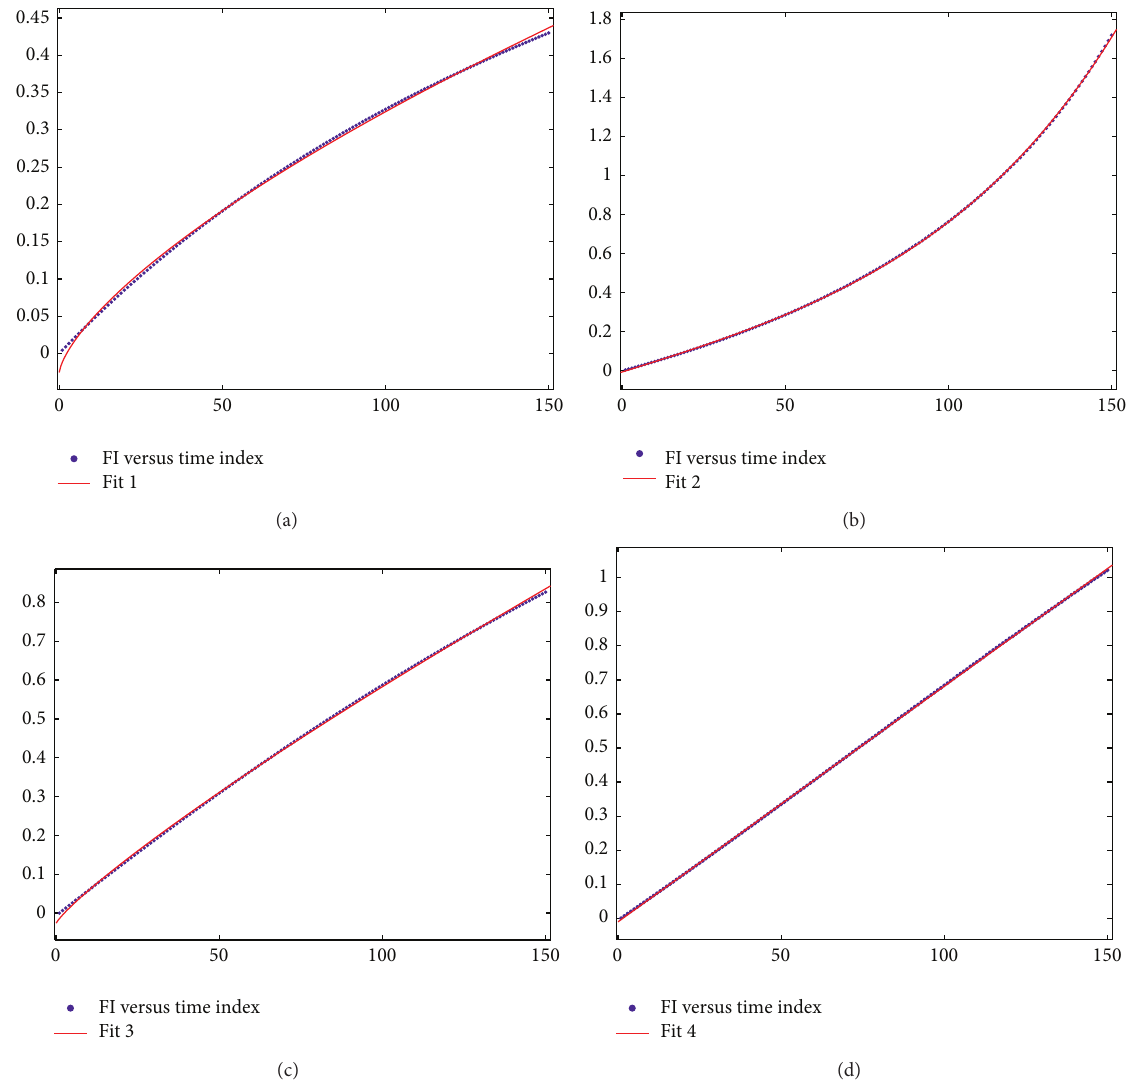
Figure 9: (a) Curve fitting of the FI degradation model about the situation that 𝑅1 deviates from 10k Ω to 4 k Ω . (b) Curve fitting of the FI degradation model about the situation that 𝑅1 deviates from 10k Ω to 16k Ω . (c) Curve fitting of the FI degradation model about the situation that 𝑅3 deviates from 10 k Ω to 4 k Ω . (d) Curve fitting of the FI degradation model about the situation that 𝑅3 deviates from 10k Ω to 16k Ω